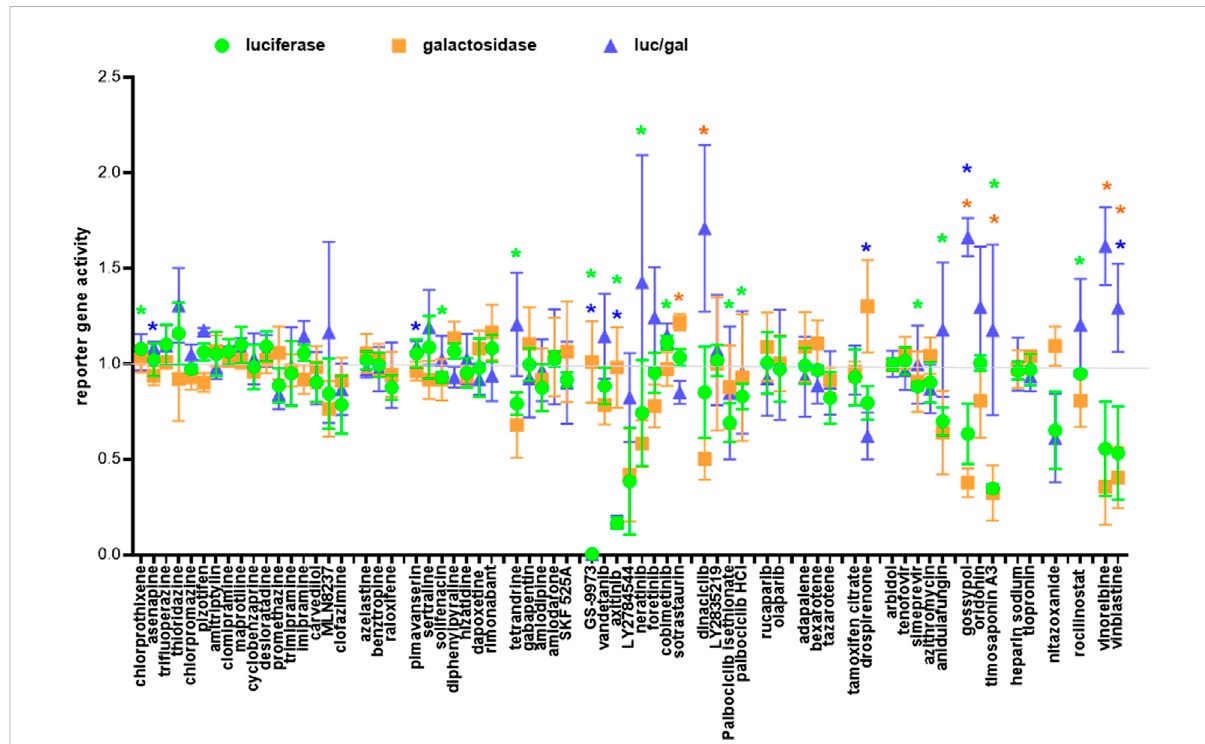
FIGURE 7 Negative screen. One of the three cell types: 293T, 293T-ACE2 and 293T-ACE2-TMPRSS2 (30,000 cells) was co-transfected with plasmids encoding the T7 polymerase, luciferase and β -galactosidase reporter genes and then treated with 10 μ M of individual drugs. Luciferase, β - galactosidase and the luciferase/ β -galactosidase ratio are presented as ratios to the solvent controls which are set as 1. Data are presented as mean +/ − SD of three repeats. * p <